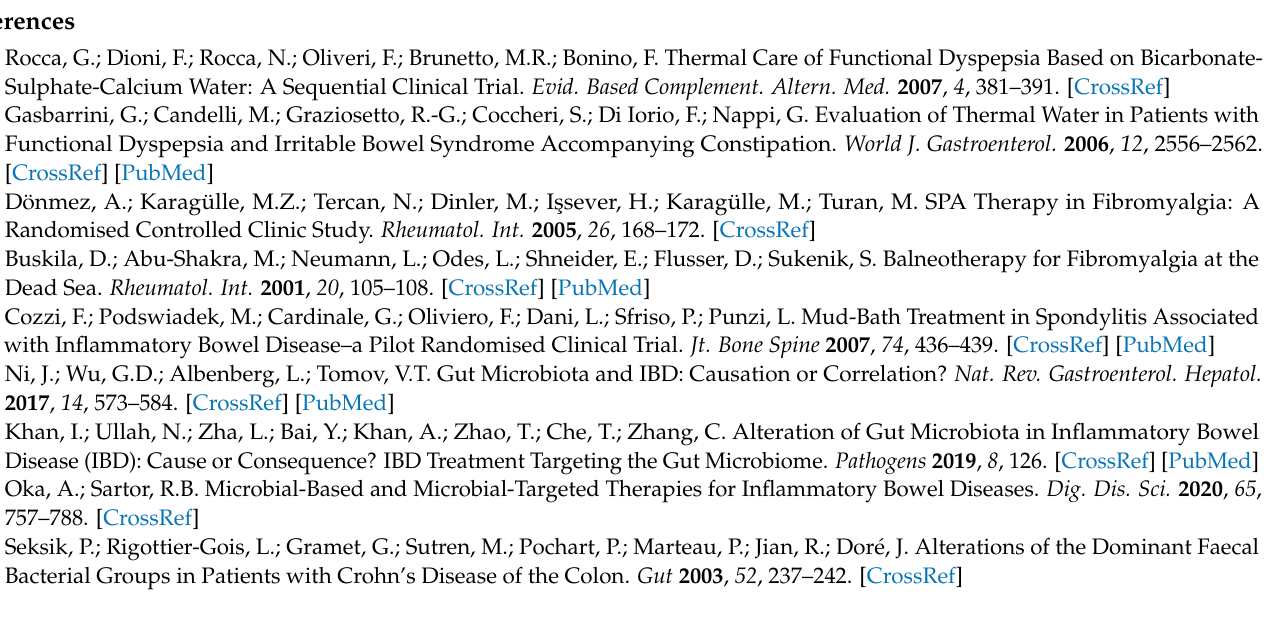
µ g of FD4/mL of serum 5 h after intragastric administration, Figure S2: Effect of the administration of NMW 1 or NMW2 on body weight and DAI in a 4% DSS-induced inflammation model, Figure S3: Effect of the administration of NMW1 or NMW2 on histological lesions. HES staining of the colonic mucosa from five different mice (NT: non treated; treated 1 %DSS, treated 1% DSS + NMW1; treated 1% DSS + NMW2). Bar represents 50 µ m, Figure S4: Analysis of the composition of the microbiota associated with the colonic mucosa of mice treated with DSS that received or did not receive NMW1 or NMW2. Differential analysis of the comparison of the microbiota (LEfSe) between the three